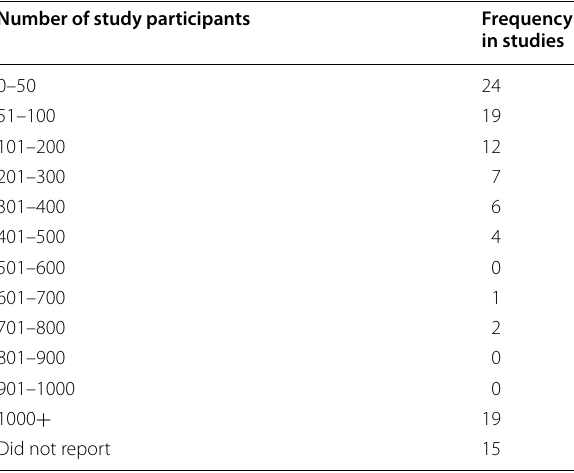
Table 1 Frequency of participants in studies analyzed Number of study participants